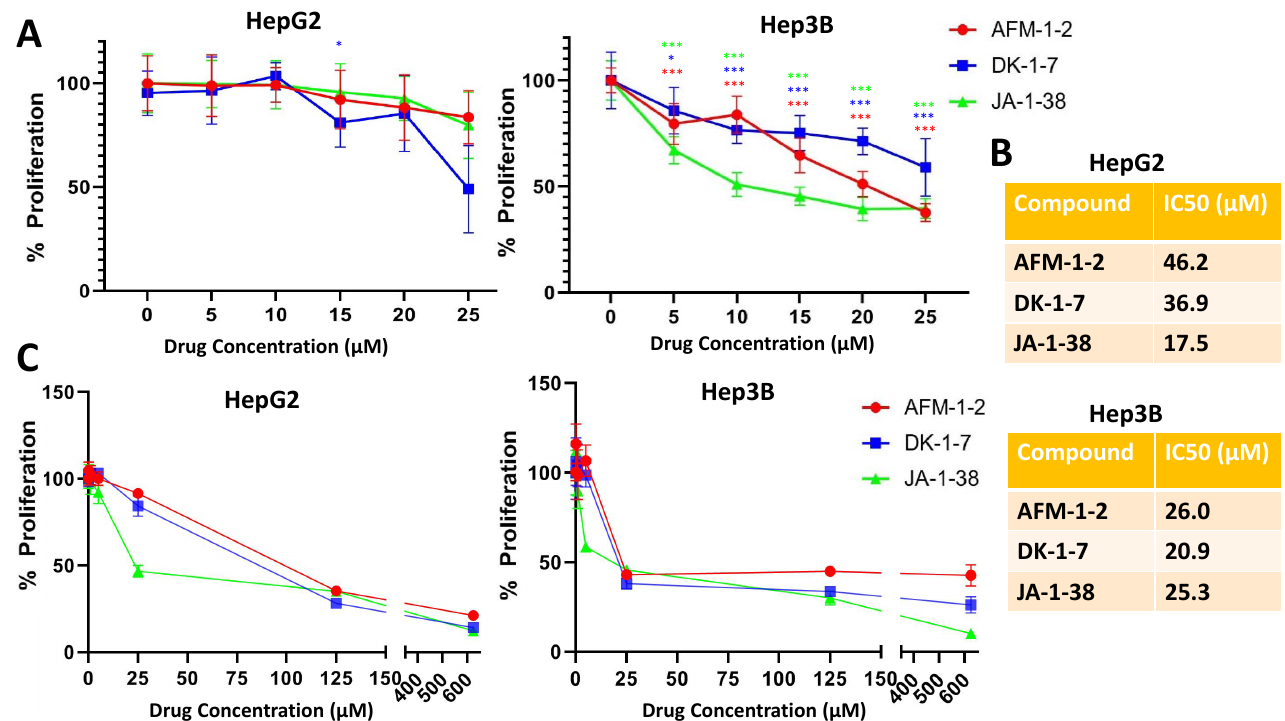
Figure 2. Cjoc42 derivatives and their antiproliferative effects. ( A ) Proliferation assay of three cjoc42 derivatives at 5–25 µ M doses after 72 h of treatment in HepG2 cells and Hep3B cells. In HepG2 cells ( left ), a statistically significant difference was found in DK-1–7 at the 15- µ M dose ( p = 0.031) and for all three compounds at the 25- µ M dose (AFM-1 and -2, p = 0.025; DK-1–7, p < 0.001; JA-1–38, p = 0.022). In Hep3B cells ( right ), a statistically significant difference in proliferation was seen at all concentrations of AFM-1 and -2 (5 µ M, <0.001; 10 µ M, <0.001; 15 µ M, <0.001; 20 µ M, <0.001; 25 µ